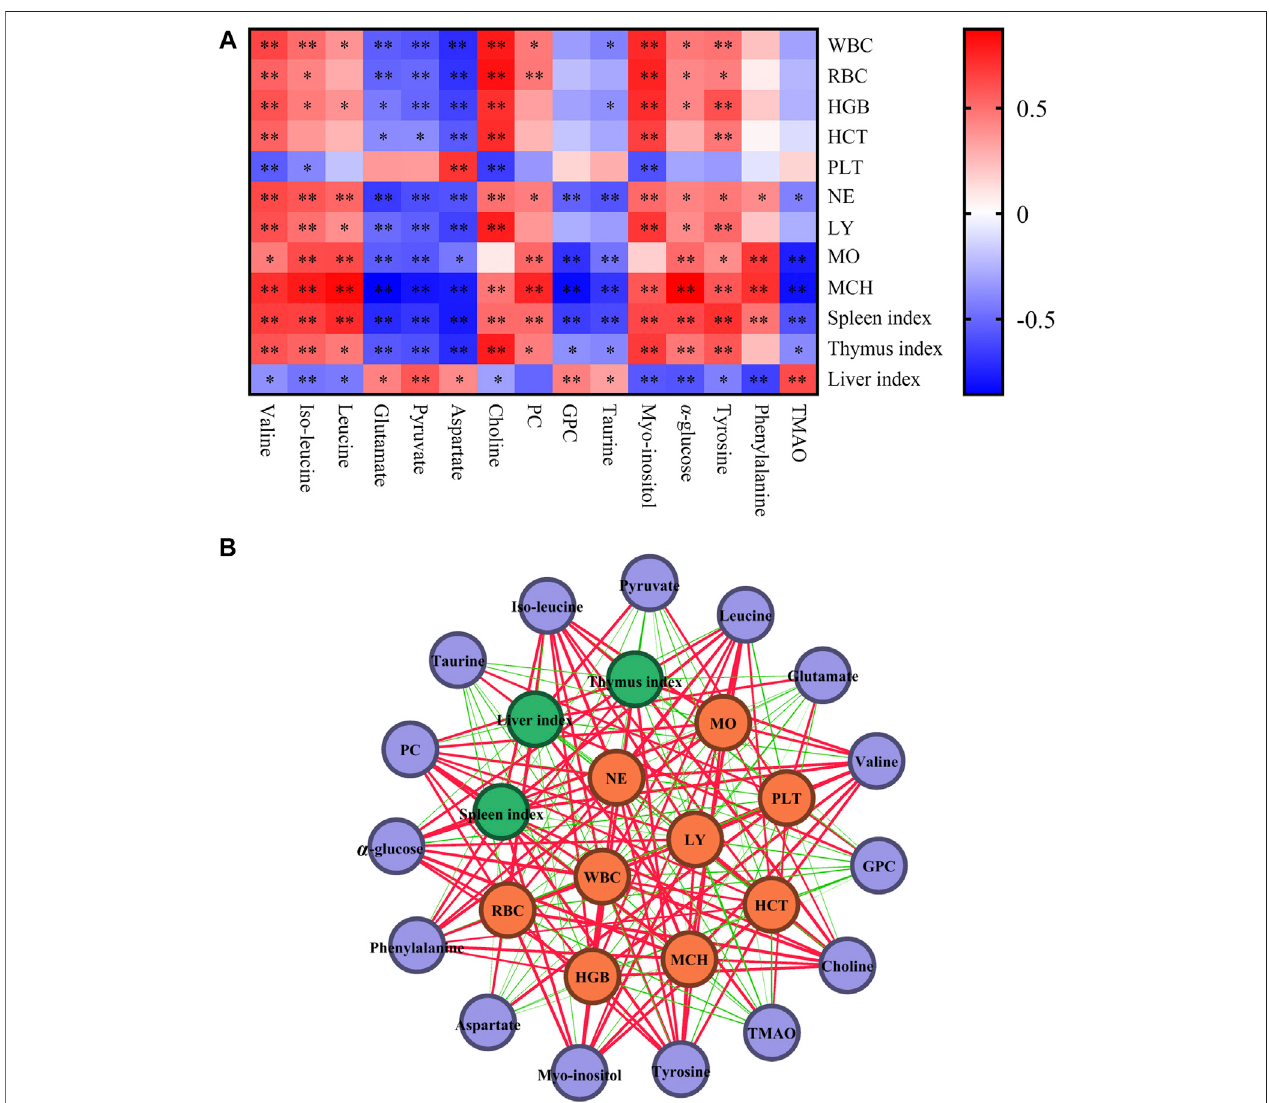
FIGURE 5 | Correlation analysis of differential metabolites, blood routine parameters and organ indexes. (A) The correlation map of differential metabolites, blood routine parameters and organ indexes. Red and blue represent positive and negative correlations respectively (* p < 0.05, ** p < 0.01). (B) Correlation network of differential metabolites, blood routine parameters and organ indexes based on Pearson ’ s correlation coef fi cients. Purple, yellow and green nodes represent differential metabolites, blood routine parameters and organ indexes. Red and green lines represent positive and negative correlations. Line thickness re fl ects the magnitude of the correlation coef fi